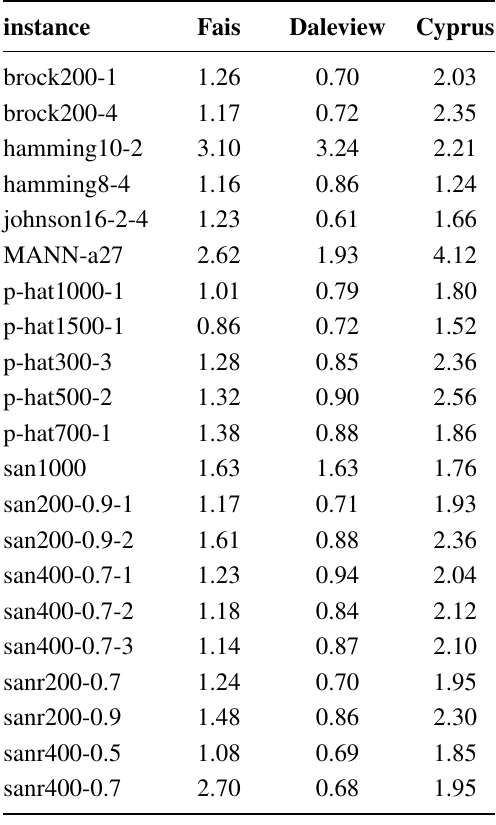
Table 10. Calibration experiment part 2, does hardware affect relative algorithmic performance? Values greater than 1 imply BBMC is faster than MCSa, and values less than 1 imply MCSa is faster. instance